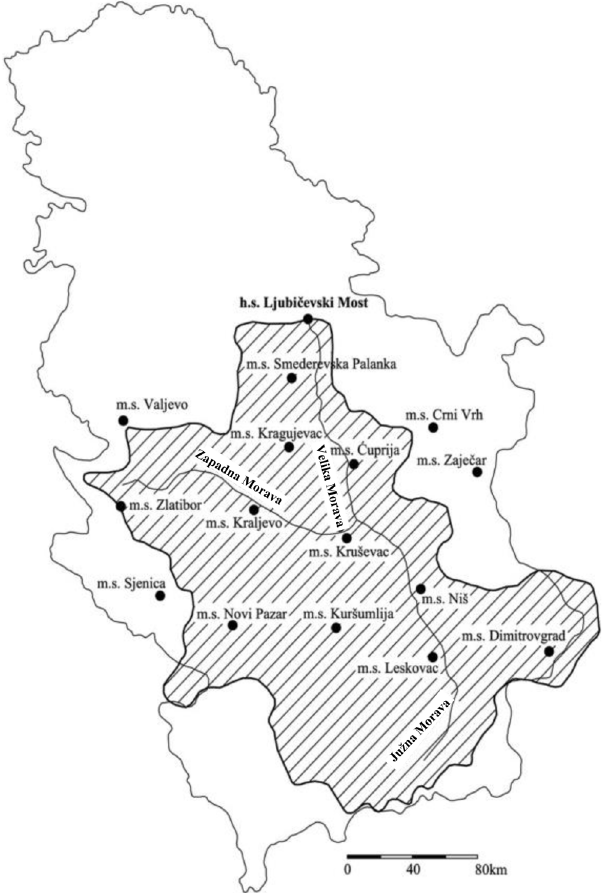
Figure 1. The Velika Morava River Basin with hydrograph network and locations of chosen climatic and hydrological